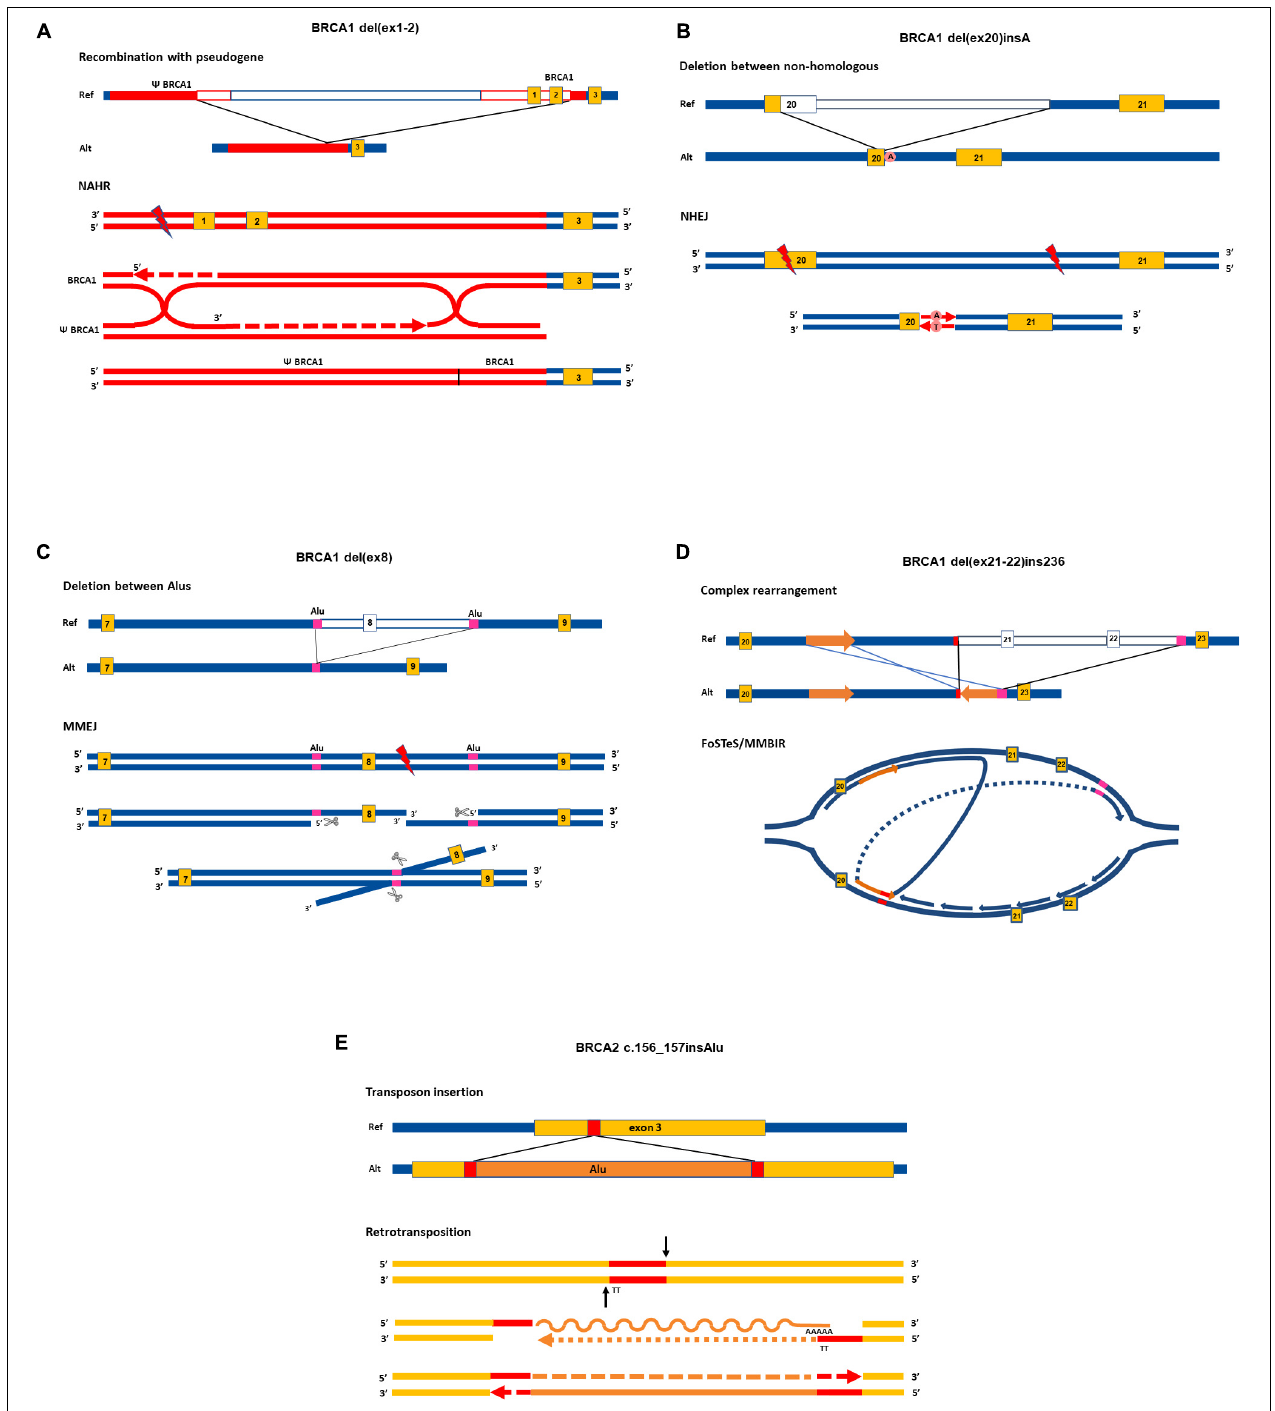
FIGURE 1 | Proposed rearrangement types in cancer susceptibility genes. Upper parts of the panels show the allelic structure in sense orientation of elected rearrangements. Lower parts of the panels depict the most probable molecular mechanisms giving rise to the respective rearrangements, focusing on the main successive steps. Enzymes and auxiliary proteins mediating the mechanisms are not indicated. Yellow boxes indicate exons, red and magenta lines denote homologies, empty lines in reference allele mark deleted regions in alternative allele. Red lightning signs stand for double-strand break. Graphical representation of exons and introns is not to scale. The running name of the rearrangements are indicated above each graph, and exact names are given in the caption with HGVS nomenclature. All SVs taken as examples are registered variations in the LOVD database. NAHR, non-allelic homologous recombination, NHEJ, non-homologous end joining; MMEJ, microhomology-mediated end-joining; MMBIR, microhomology-mediated brake-induced repair; FoSTeS, fork stalling and template switching.